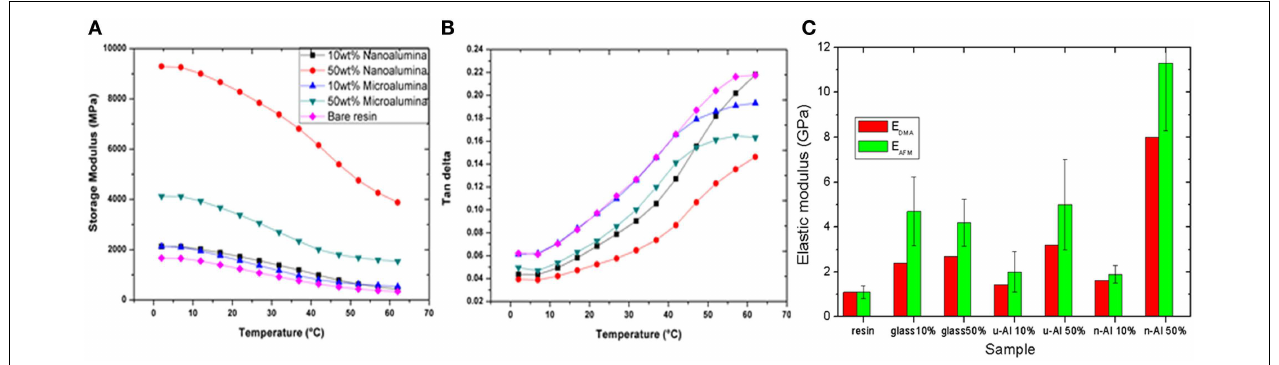
tangent, i.e., ratio of complex viscous modulus to real elastic modulus). In (C) , the values of elastic modulus as obtained from DMA in (A) (RT value) are compared to the modulus obtained by AFM force-distance nanoindentation. Reprinted fromThorat et al. (2013a).